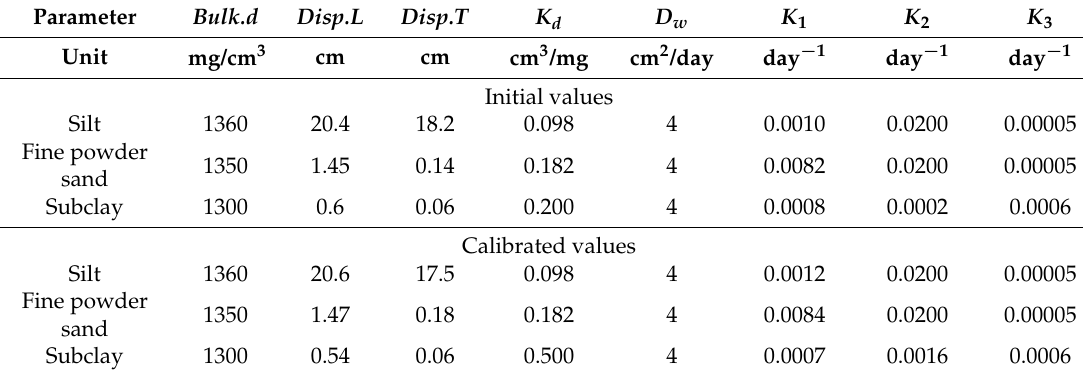
Table 2. Solute transport